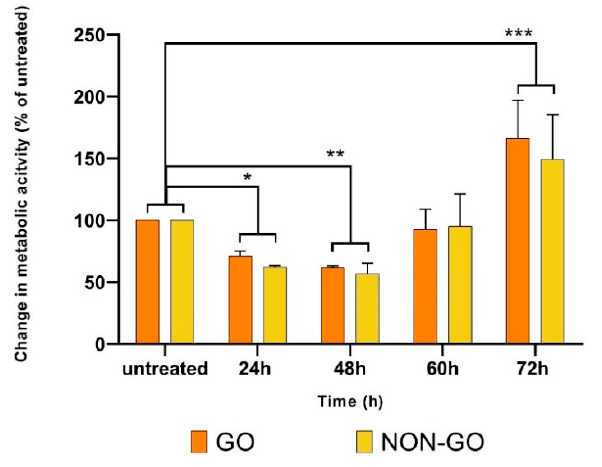
Figure 4. The effect of 50% CC smoke extract on the metabolic activity of GO and NON-GO fibroblasts There was no difference in effect based on the origin of the cells. All experiments were performed in triplicates. Data were analyzed using repeated measures ANOVA followed Tukey’s multiple comparisons post hoc test; the 100% means the untreated cells metabolic activity, and the result shown as % of untreated (mean ± SD) * p < 0.03, ** p < 0.02, *** p < 0.005.